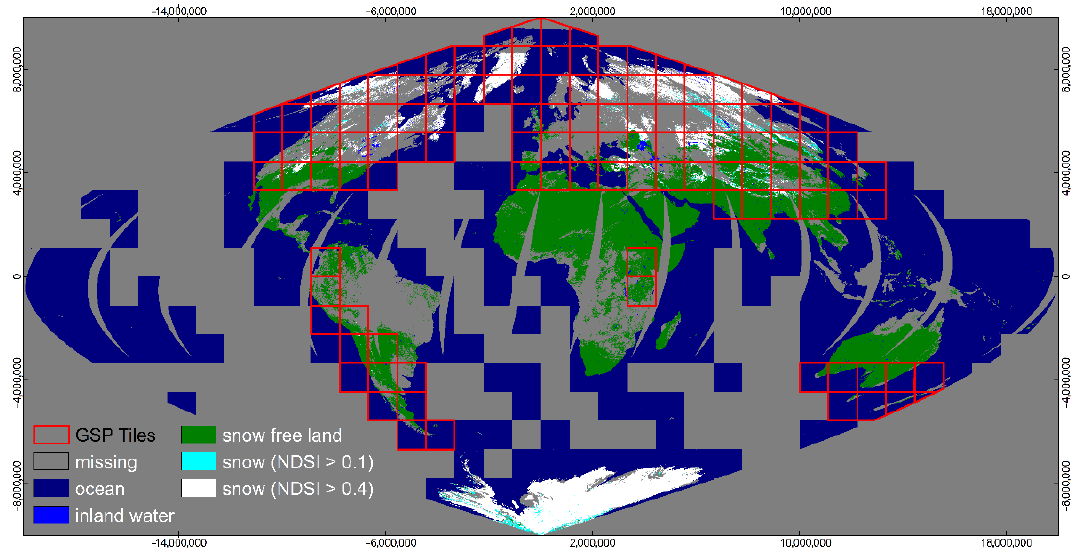
Figure 1. Global Mosaic of Terra Snow Product MOD10A1 from 12 March 2008. The 119 tiles used for GSP are framed in red (Antarctica is not included in this study).